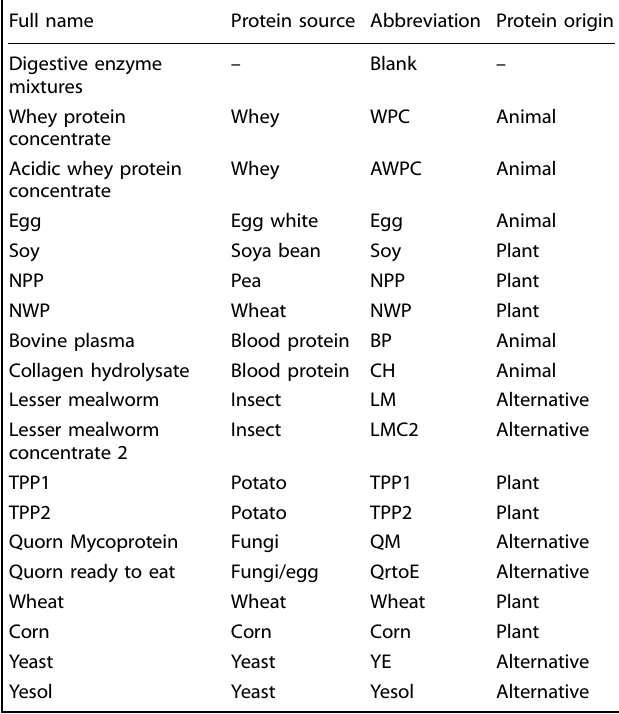
Table 1. Overview of the 18 dietary proteins